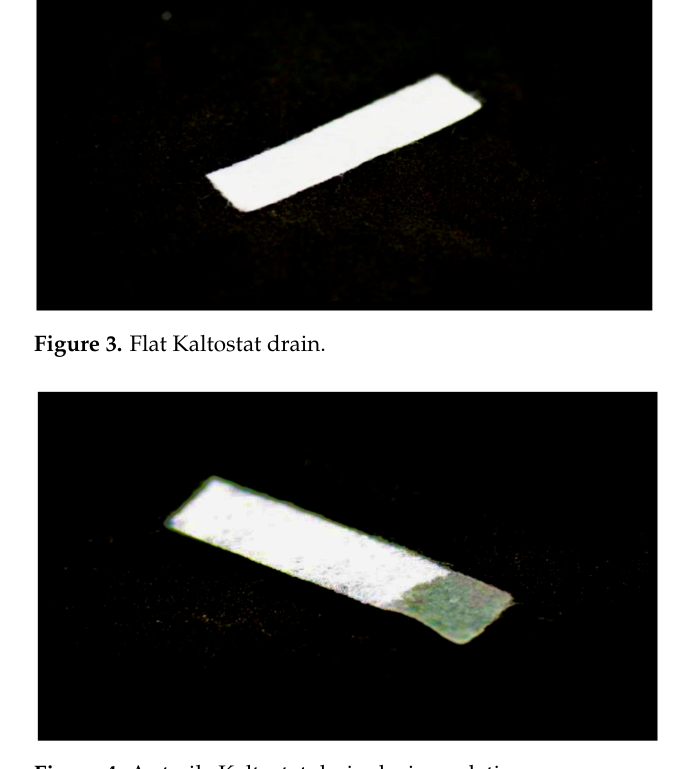
Figure 4. A sterile Kaltostat drain during gelation.